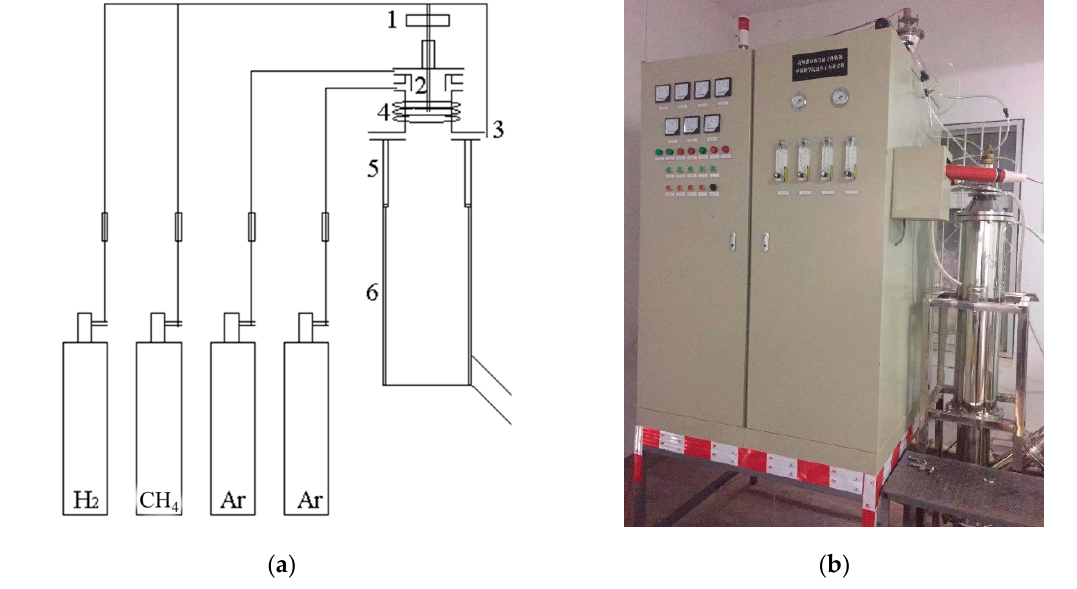
Figure 1. Schematic illustration ( a ) and picture ( b ) of the radiofrequency (RF) thermal plasma processing system: (1) powder feeder; (2) injection probe; (3) circular nozzle; (4) water-cooled induction coil; (5) hot-chamber reactor; (6) cooling-chamber reactor.